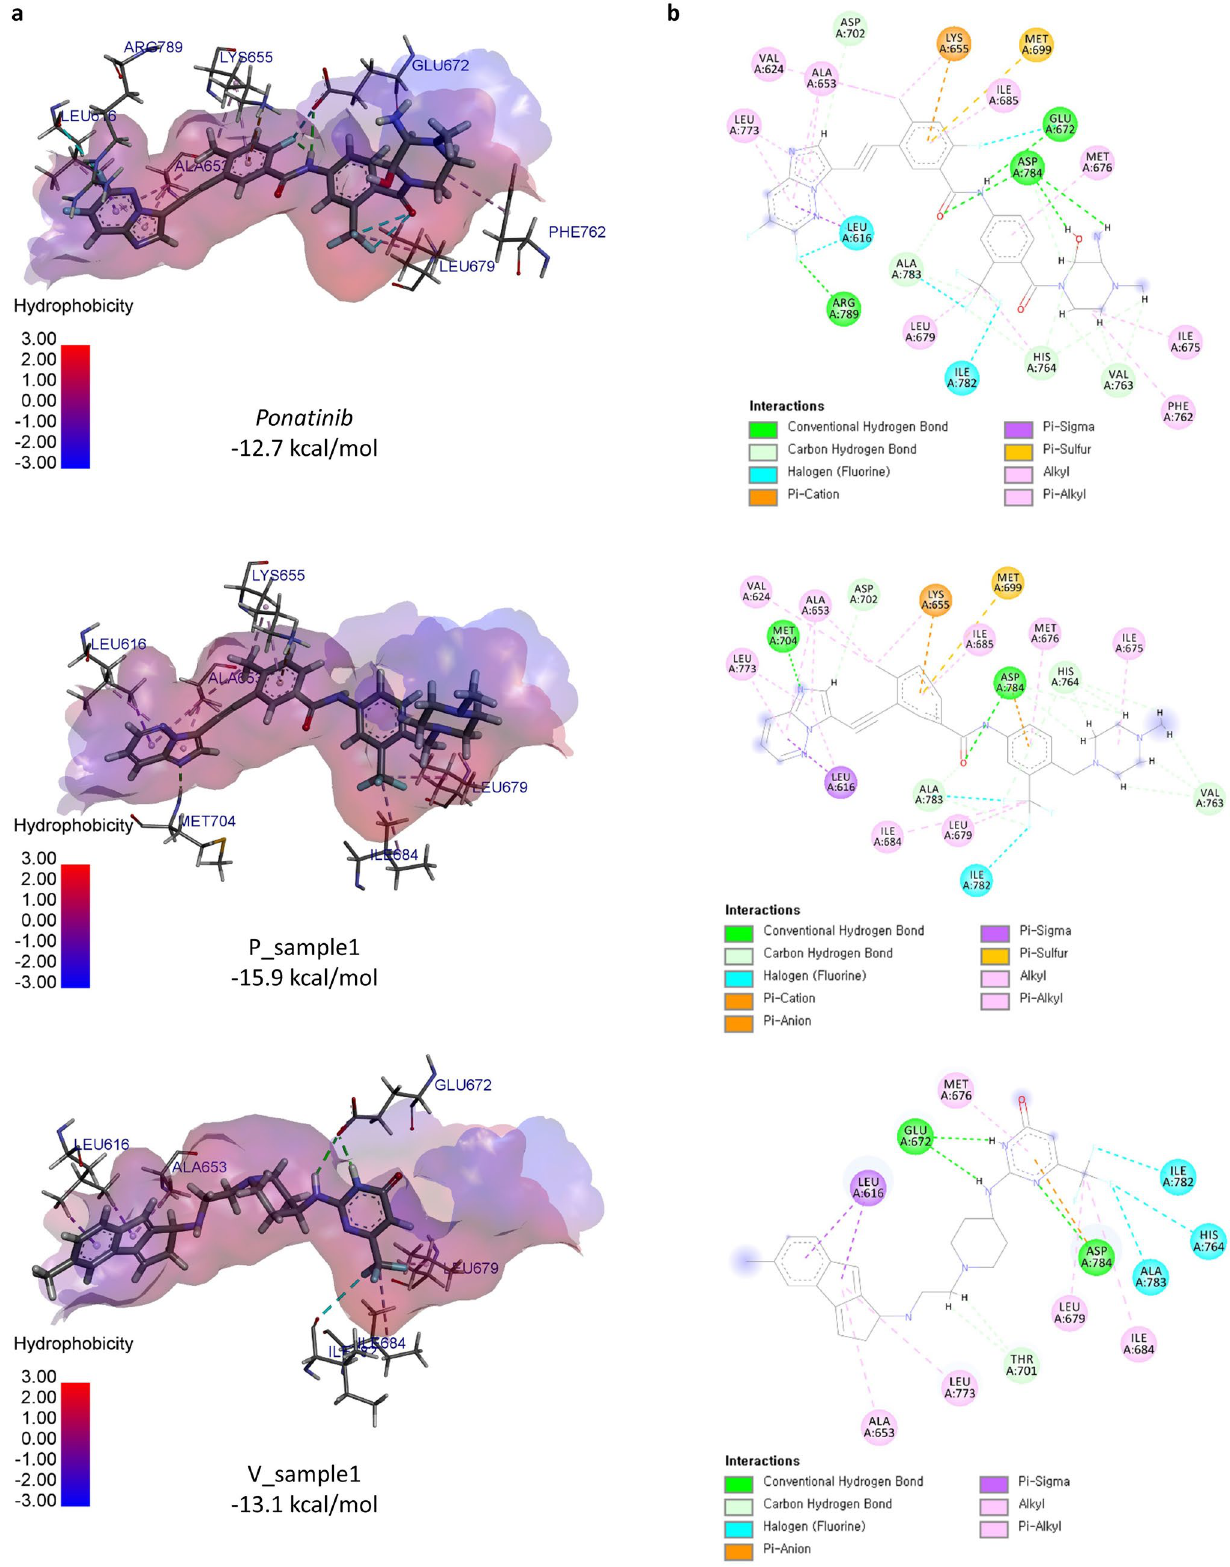
Figure 5. Docking poses of ponatinib, P_sample1, and V_sample1. ( a ) The X-ray crystallographic pose of ponatinib from PDB ID:3ZOS (native), P_sample1 (optimized from ponatinib) docked into 3zos, and V_ sample1 (optimized from ZINC12114041) docked into 3zos. ( b ) Binding interactions of ponatinib, P_sample1, and V_sample1 to